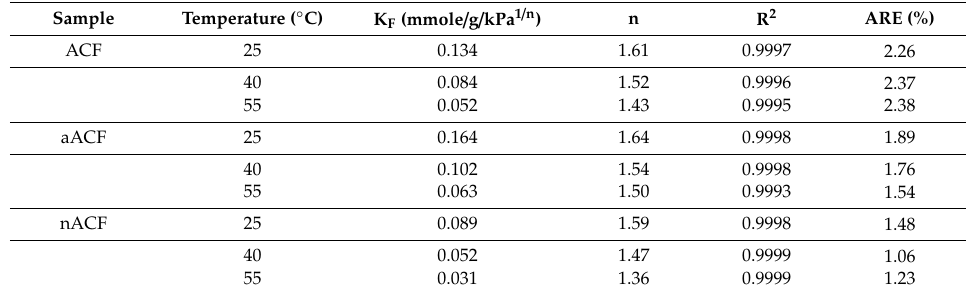
Table 2. Curve-fitting of the Frenudlich equation for the CO 2 adsorption data at di ff erent temperatures.